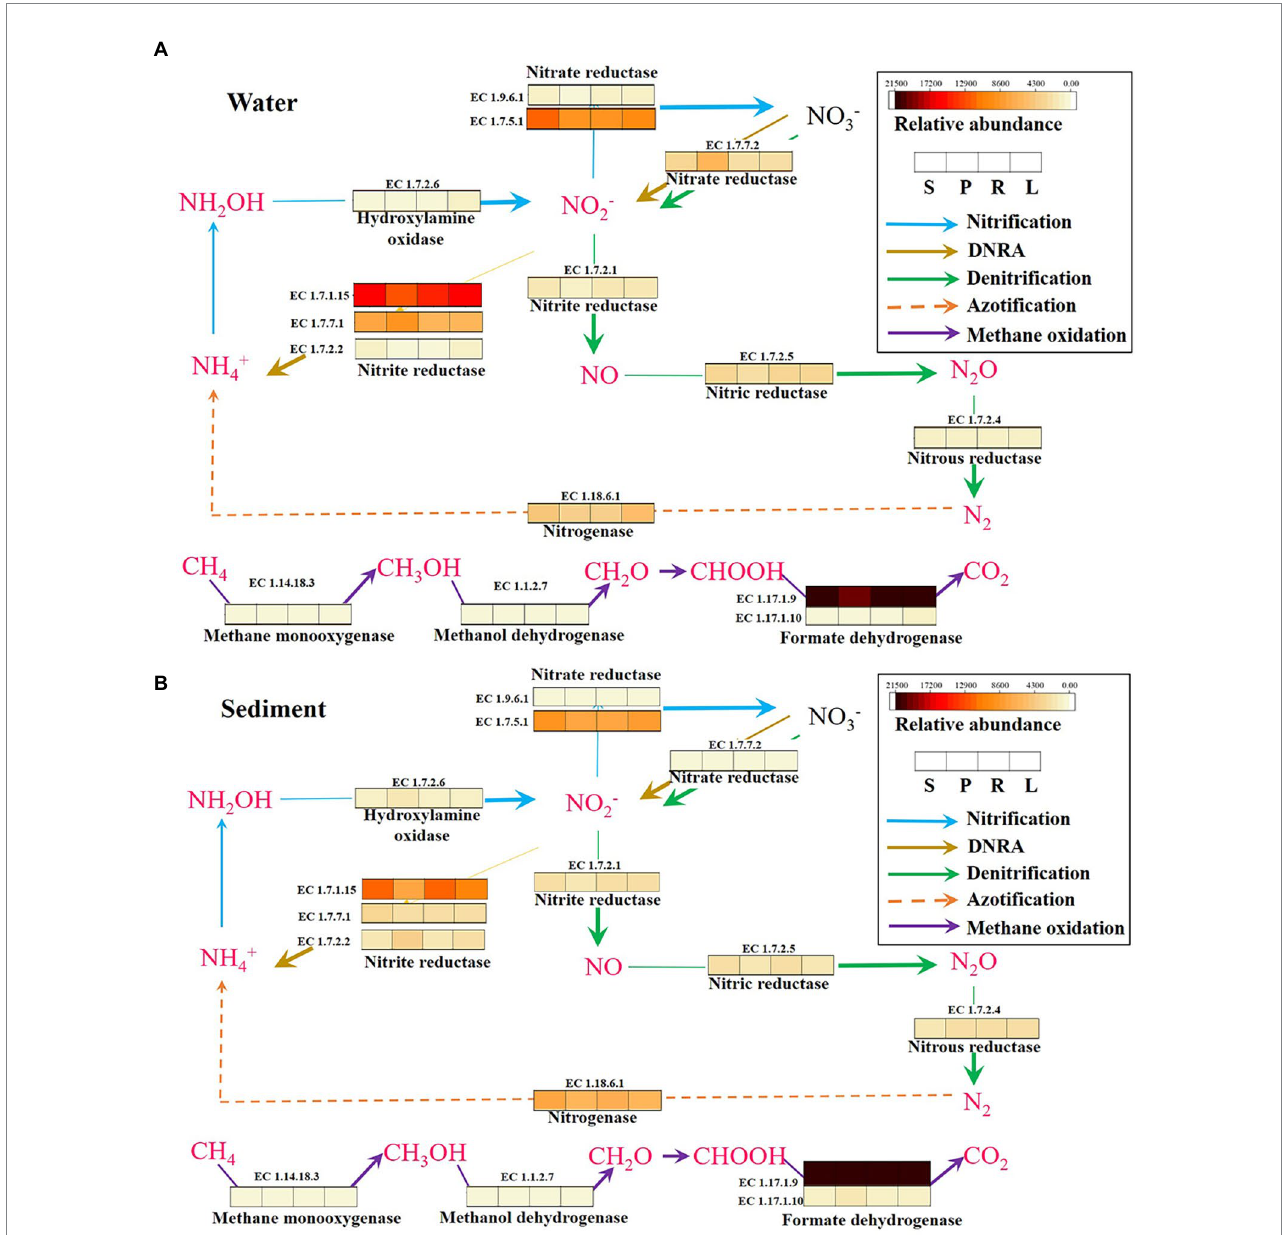
FIGURE 8 KEGG pathways and functional genes related to N 2 O and CH 4 metabolism in the water (A) and sediment (B) of four habitats. DNRA, dissimilatory nitrate reduction to